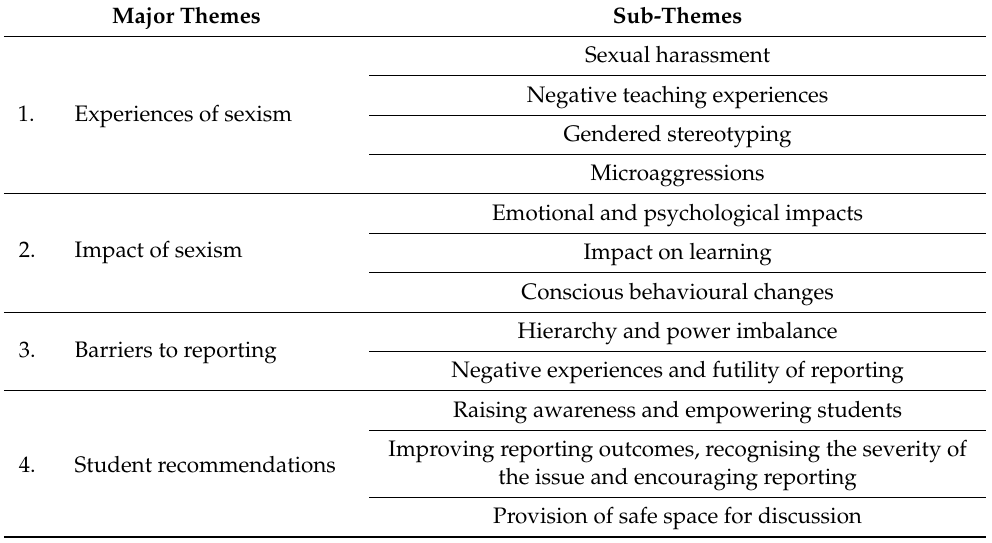
Table 3. Summary of Major themes and